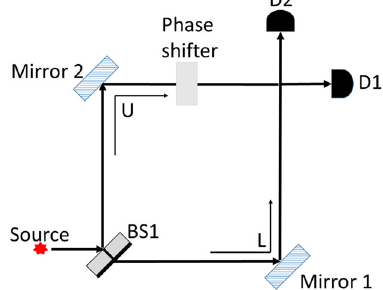
FIG. 2. MZI setup with beam splitter 2 (BS2)